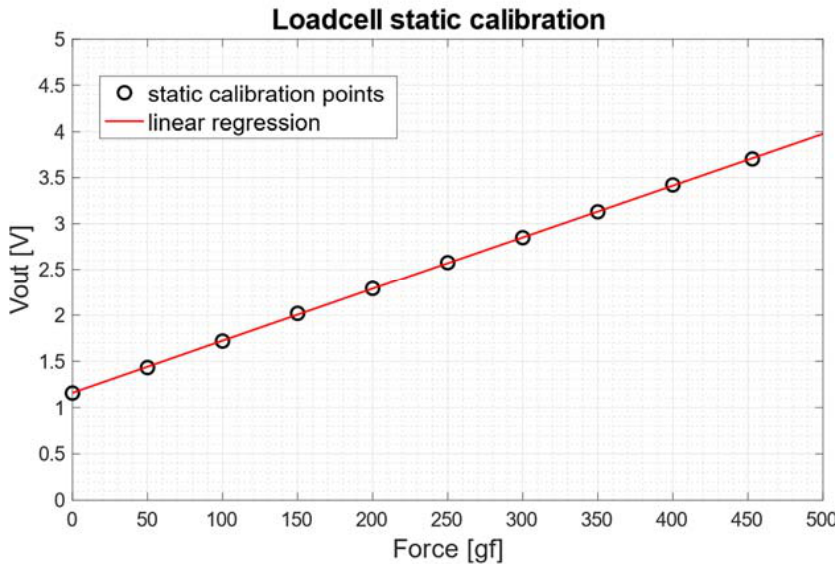
Figure 7. Static calibration of the loadcell: scatter plot of the experimental data (circles) and linear regression (continuous red line).